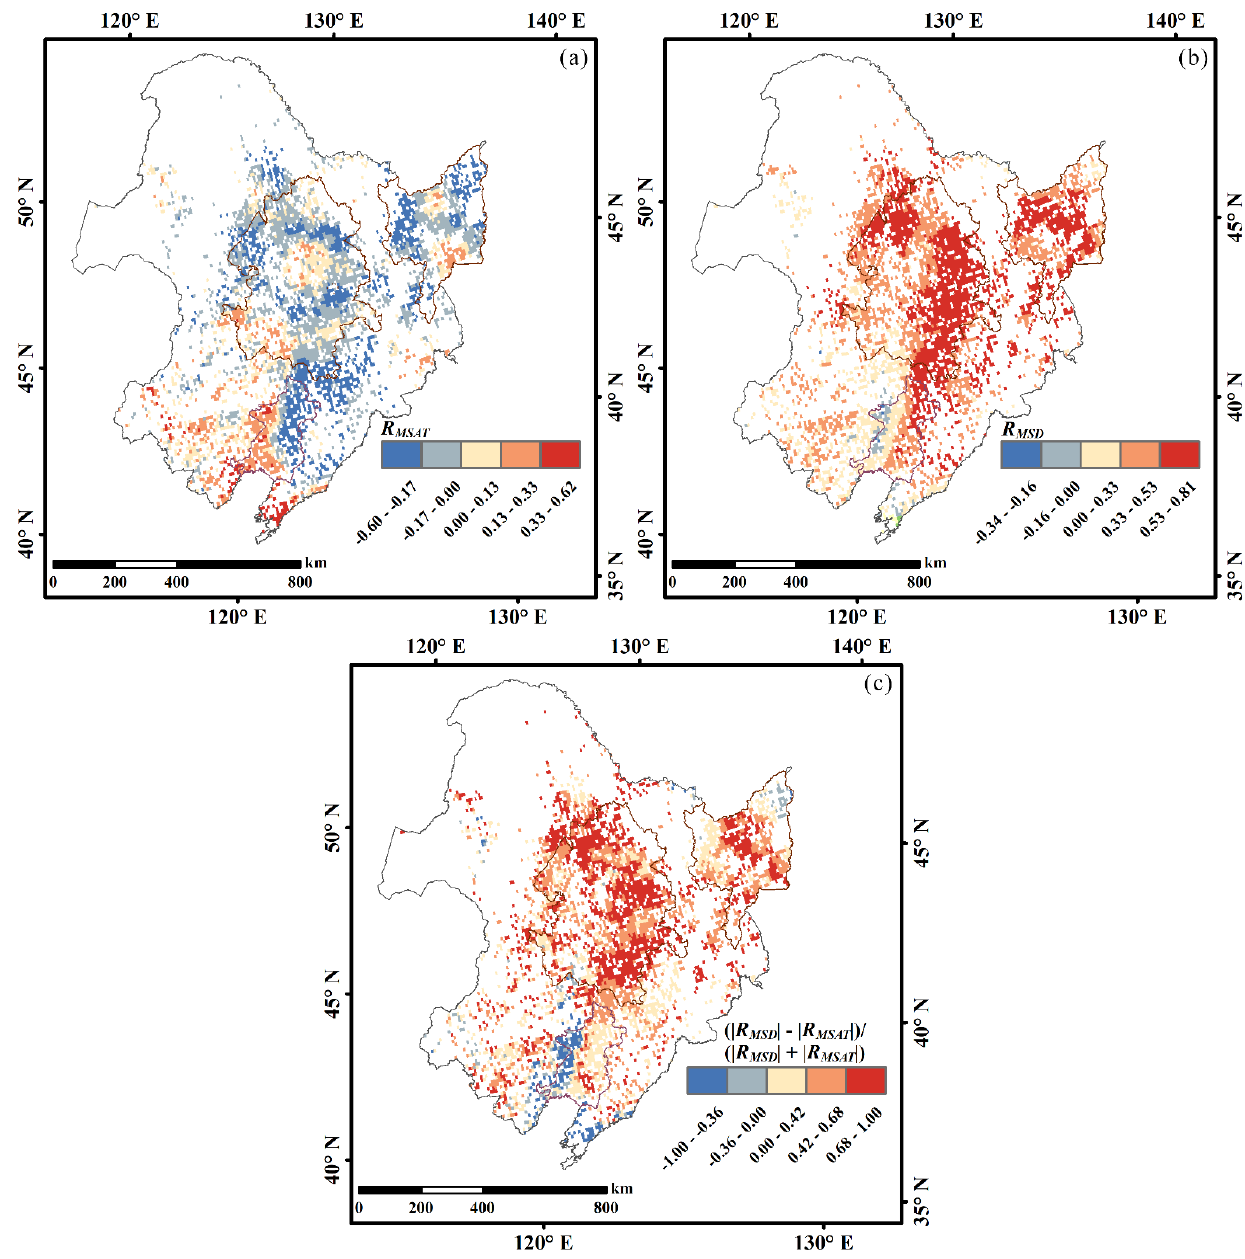
Figure 7. The results of the Pearson correlation coefficient analysis of ( a ) T SA and T SS (R MSAT ) and ( b ) M SD and T SS (R M SD ). ( c ) is the relative importance of T SA and M SD for T SS ((|R M SD |−|R MSAT |)/(|R M SD |+|R MSAT |)); this ratio varies from 1 (when all of the variation is caused by M SD ) to −1 (when all variation is caused by T SA ). Table 3. The percentage of Pearson correlation coefficient analysis of T SA and T SS (R MSAT ) greater than (less than) M SD and T SS (R M SD ) in three plains in NEC.